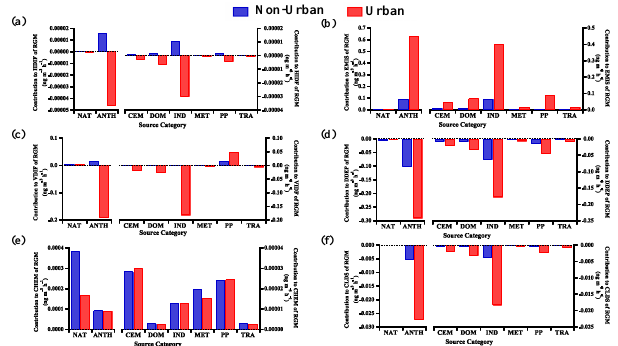
Figure 9. Impact of emission sources on (a) HADV, (b) EMIS, (c) VDIF, (d) DDEP, (e) CHEM and (f) CLDS processes of